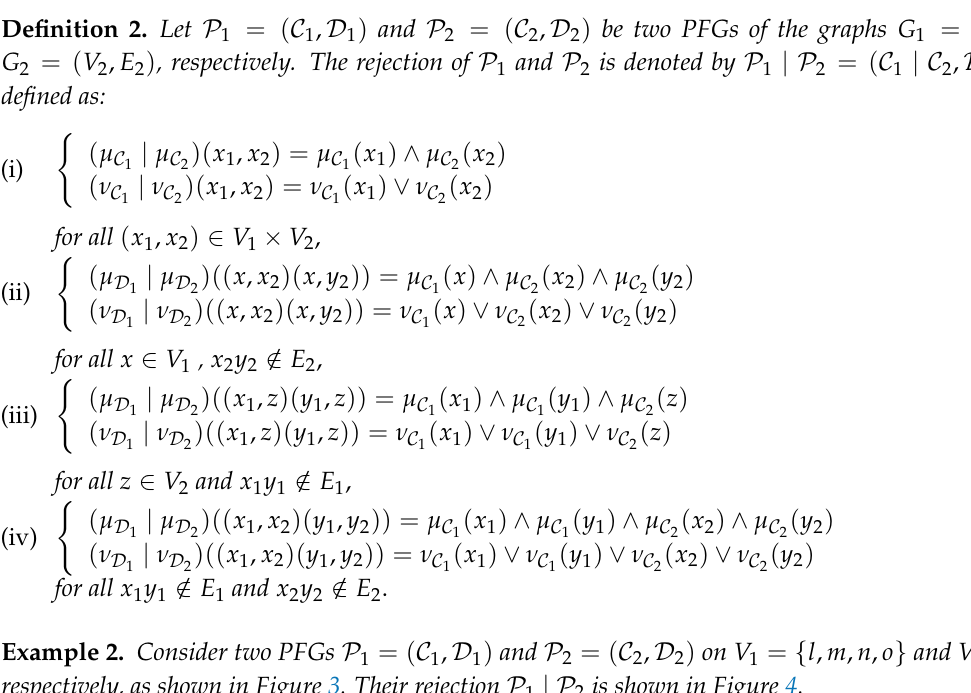
Figure 2. Pythagorean fuzzy graph (PFG) (intuitionistic fuzzy graph of second type, Figure 2.1: PFG(IFG2K)